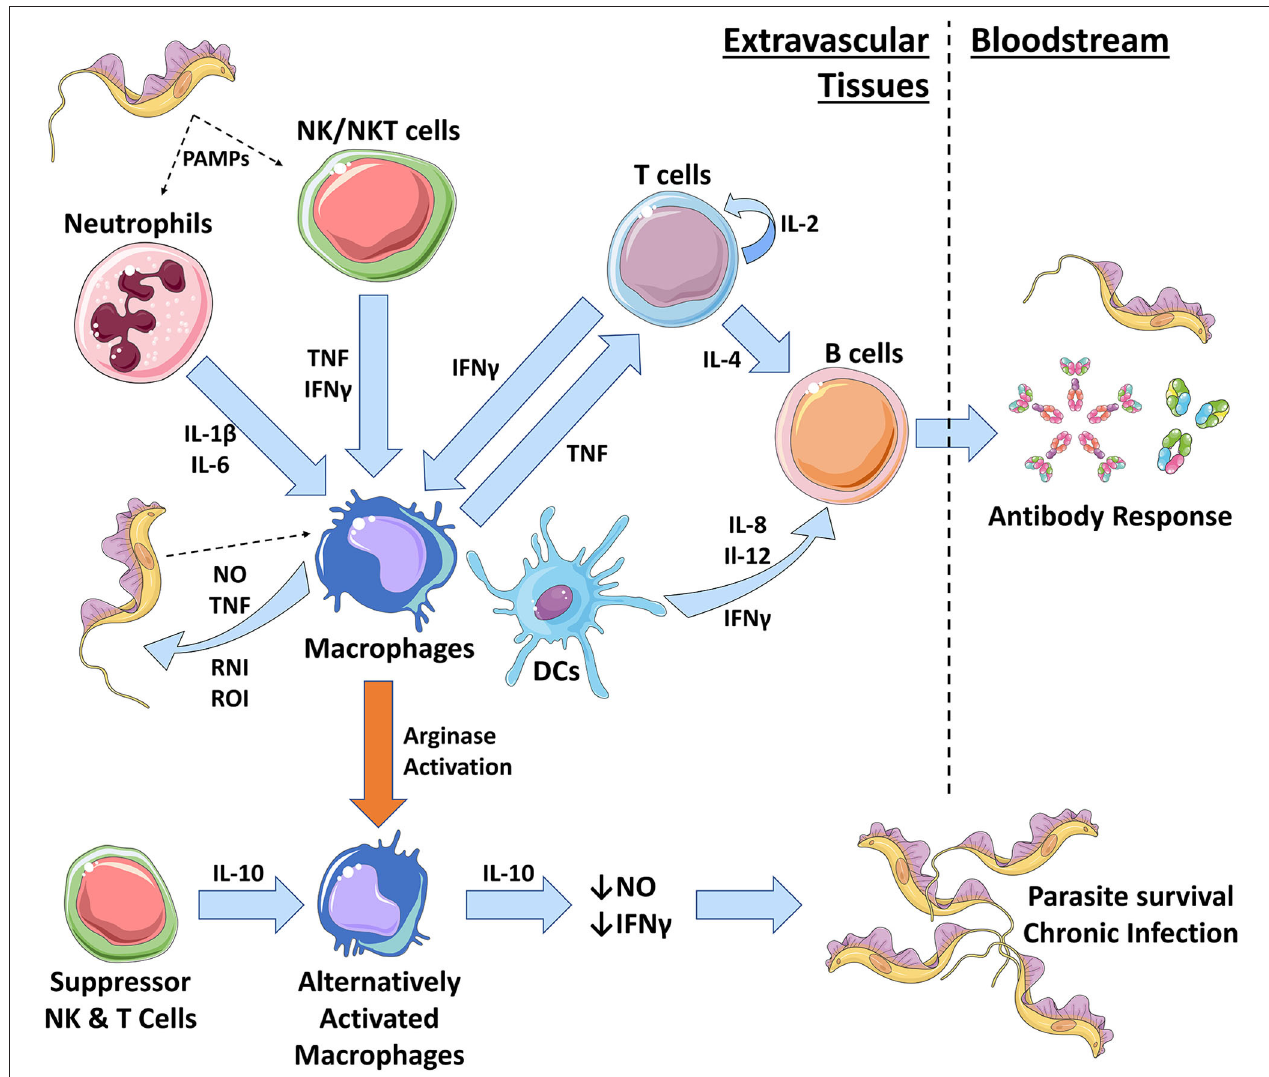
FIGURE 2 | The role of innate immune cells during African trypanosomiasis. During early trypanosome infection, a strong Th 1 immune response is initiated by the host. In the skin, neutrophils and NK cells are the first to respond to trypanosomal pathogen-associated molecular patterns (PAMPs), such as VSG and CpG DNA. Neutrophils are heavily involved in repairing the initial wound caused by the tsetse fly bite and also produce pro-inflammatory IL-1 β and IL-6. NK cells produce pro-inflammatory TNF and IFN- γ that results in the classical activation of pro-inflammatory macrophages (M θ ) via iNOS activation. Macrophages can also be activated through interactions with trypanosomal PAMPs. Classically activated macrophages produce further pro-inflammatory molecules, including TNF, nitric oxide (NO), and reactive nitrogen intermediates (RNIs) and reactive oxygen intermediates (ROIs). These chemicals can directly kill trypanosomes in extravascular spaces and tissues and allows for parasite control. Macrophage secretion of TNF can also recruit and activate T cells which self-renew via autocrine IL-2 secretion. T cells produce IFN- γ to further activate macrophages and IL-4 to activate B cells. Macrophages and dendritic cells (DCs) will further activate B cells during a Th 1 response, via IL-6, IL-12, and IFN- γ , to promote the production of antibodies that can target the VSG trypanosomes, inducing waves of parasite clearance in the bloodstream. However, antigenic variation hinders the effective clearance of trypanosome populations. Macrophages can also become alternatively activated, resulting in a Th2 immunosuppressive response. Cytokines such as IL-10, IL-4, and TGF- β initiate this type of response by promoting arginase activation in macrophages. As a result, alternatively activated macrophages produce immunosuppressive IL-10 and suppress production of trypanostatic NO and IFN- γ . This promotes parasite growth and survival, leading to a chronic